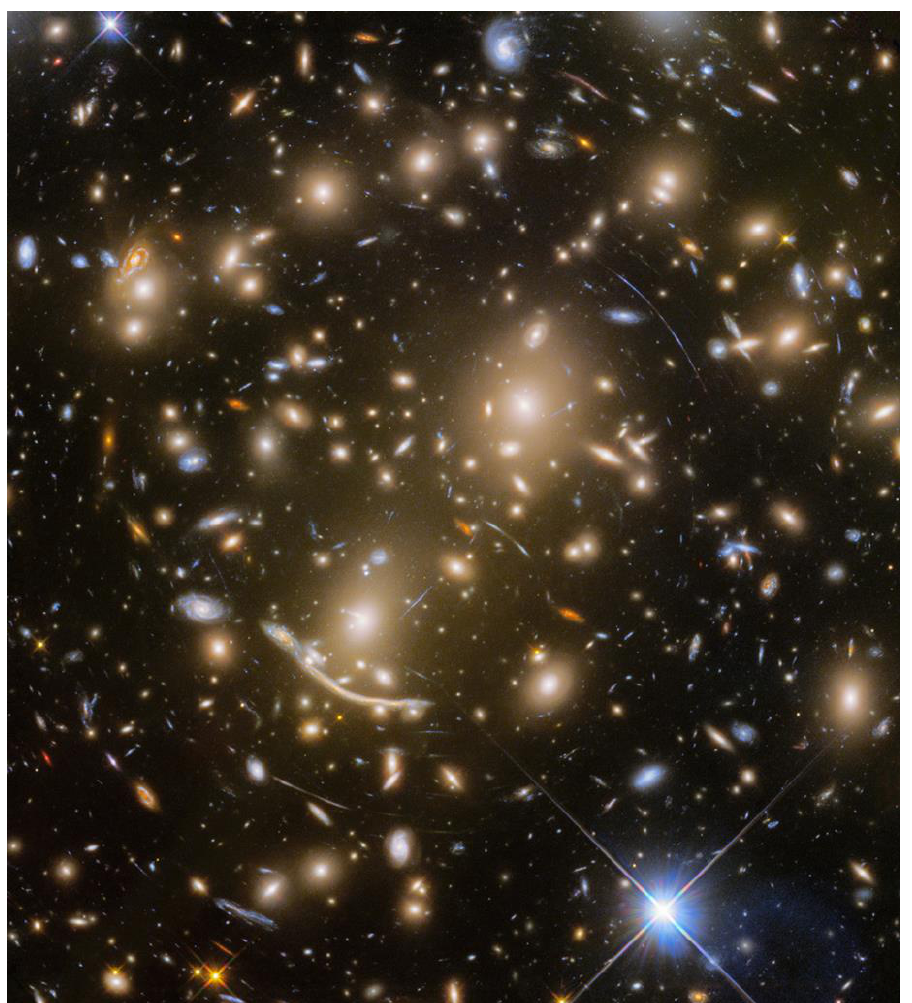
Figure 12. Bright luminous arcs stretching between galaxies in cluster Abell 370. Credit: NASA, ESA / Hubble, HST Frontier